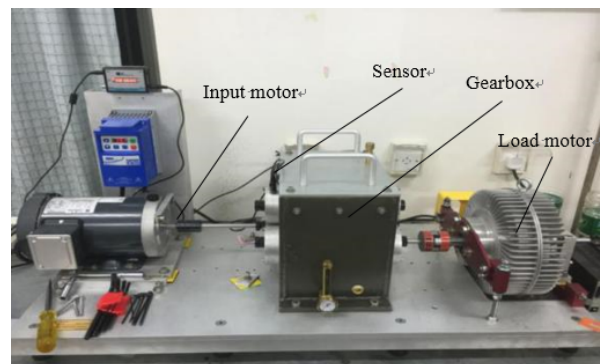
Figure 12. Gearbox test bench.